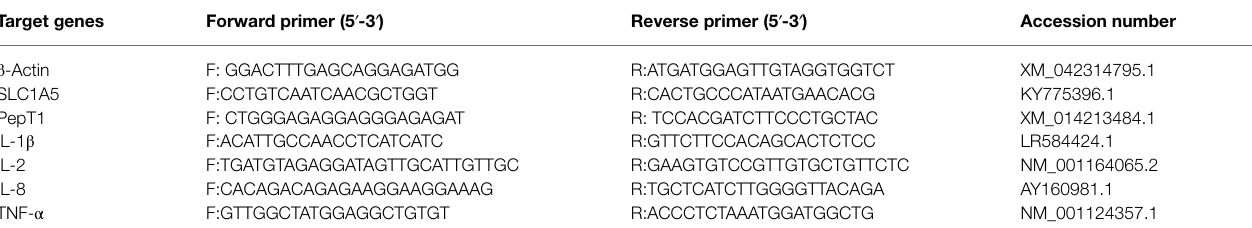
TABLE 2 | Primers sequence and annealing temperature in